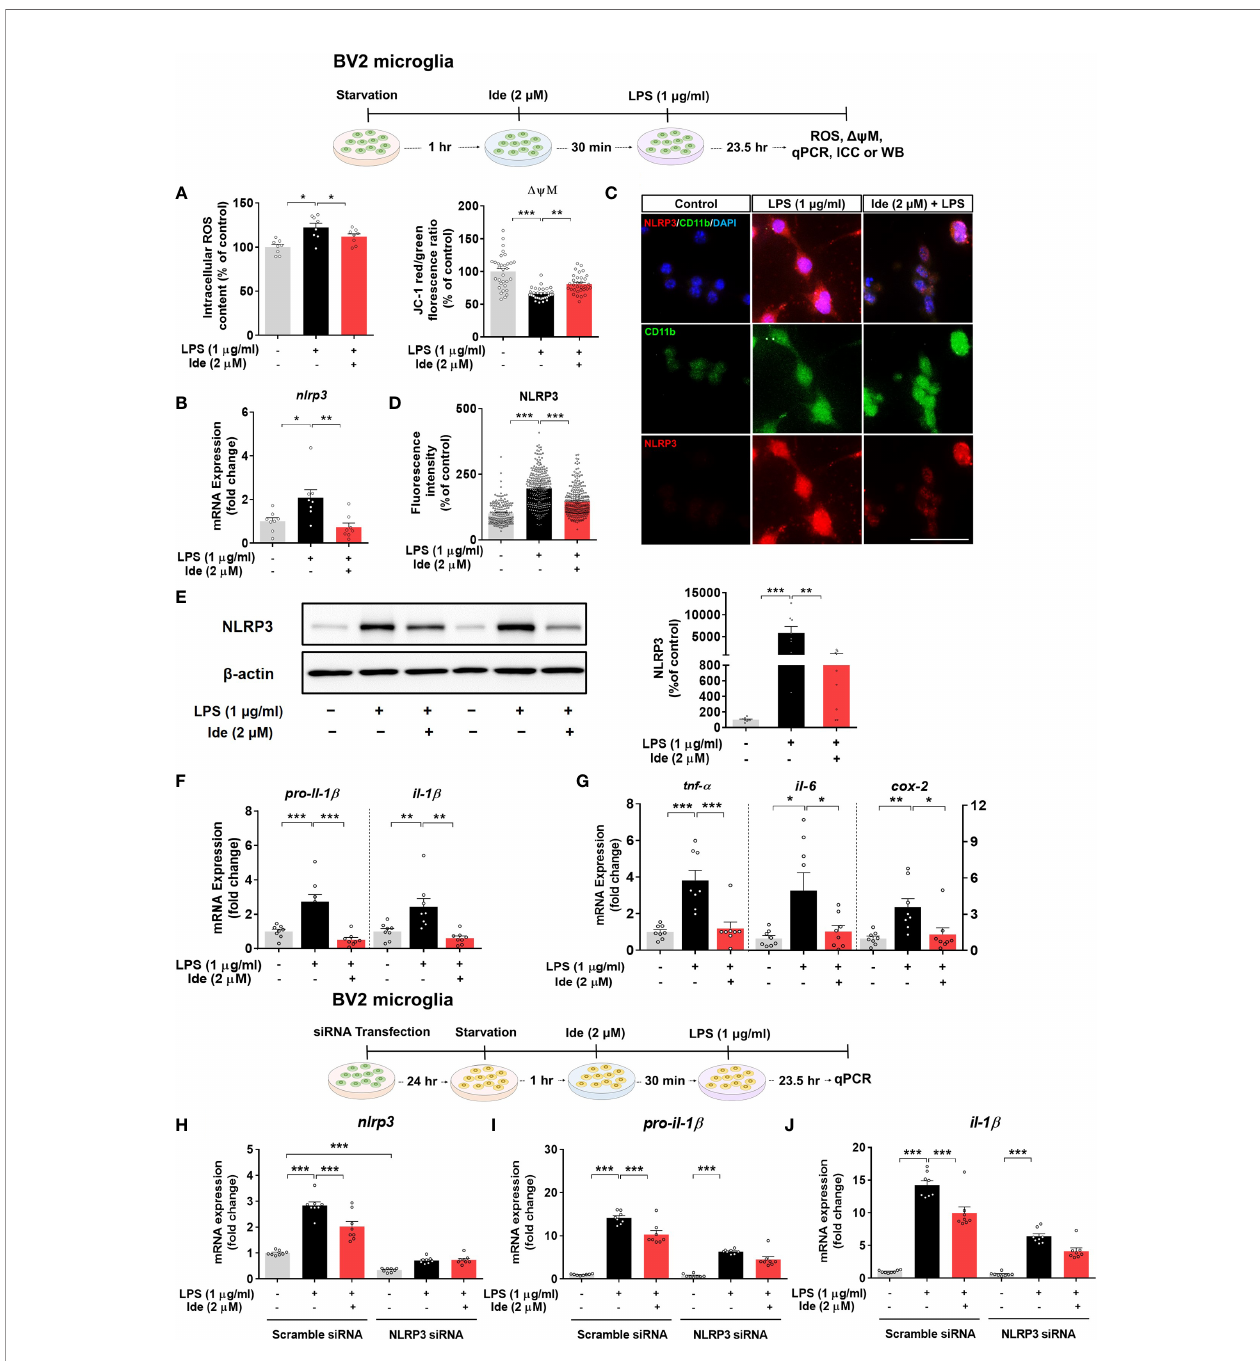
FIGURE 6 | Idebenone alters LPS-evoked ROS/mitochondrial membrane potential and regulates LPS-mediated in fl ammatory responses in an NLRP3-dependent manner in BV2 microglial cells. Cells pretreated with idebenone (2 m M) or vehicle (1% DMSO) for 30 min were treated with LPS (1 m g/ml) or PBS for 23.5 h. ROS and mitochondrial membrane potential were then analyzed, and real-time PCR, immunocytochemistry, and western blotting were performed. (A) Relative intracellular ROS levels and mitochondrial membrane potential (ROS, n = 8/group; mitochondrial membrane potential, n = 32/group). (B) Relative nlrp3 mRNA levels (n = 8/ group). (C, D) Representative immunocytochemistry image and quanti fi cation of NLRP3 expression (Veh, n = 166; LPS, n = 256; and Ide + LPS, n = 267). (E) Representative immunoblots and quanti fi cation of NLRP3 protein levels (n = 8/group). (F) Relative mRNA levels of pro-il-1 b and il-1 b (n = 8/group). (G) Relative mRNA levels of tnf- a , il-6 , and cox-2 (n = 8/group). (H – J) Relative nlrp3, pro-il-1 b and il-1 b mRNA levels in BV2 microglial cells transfected with control (scramble) or NLRP3 siRNA and treated with idebenone followed by LPS (n = 8/group). *p < 0.05, **p < 0.01, and ***p < 0.001. Scale bar = 50 m